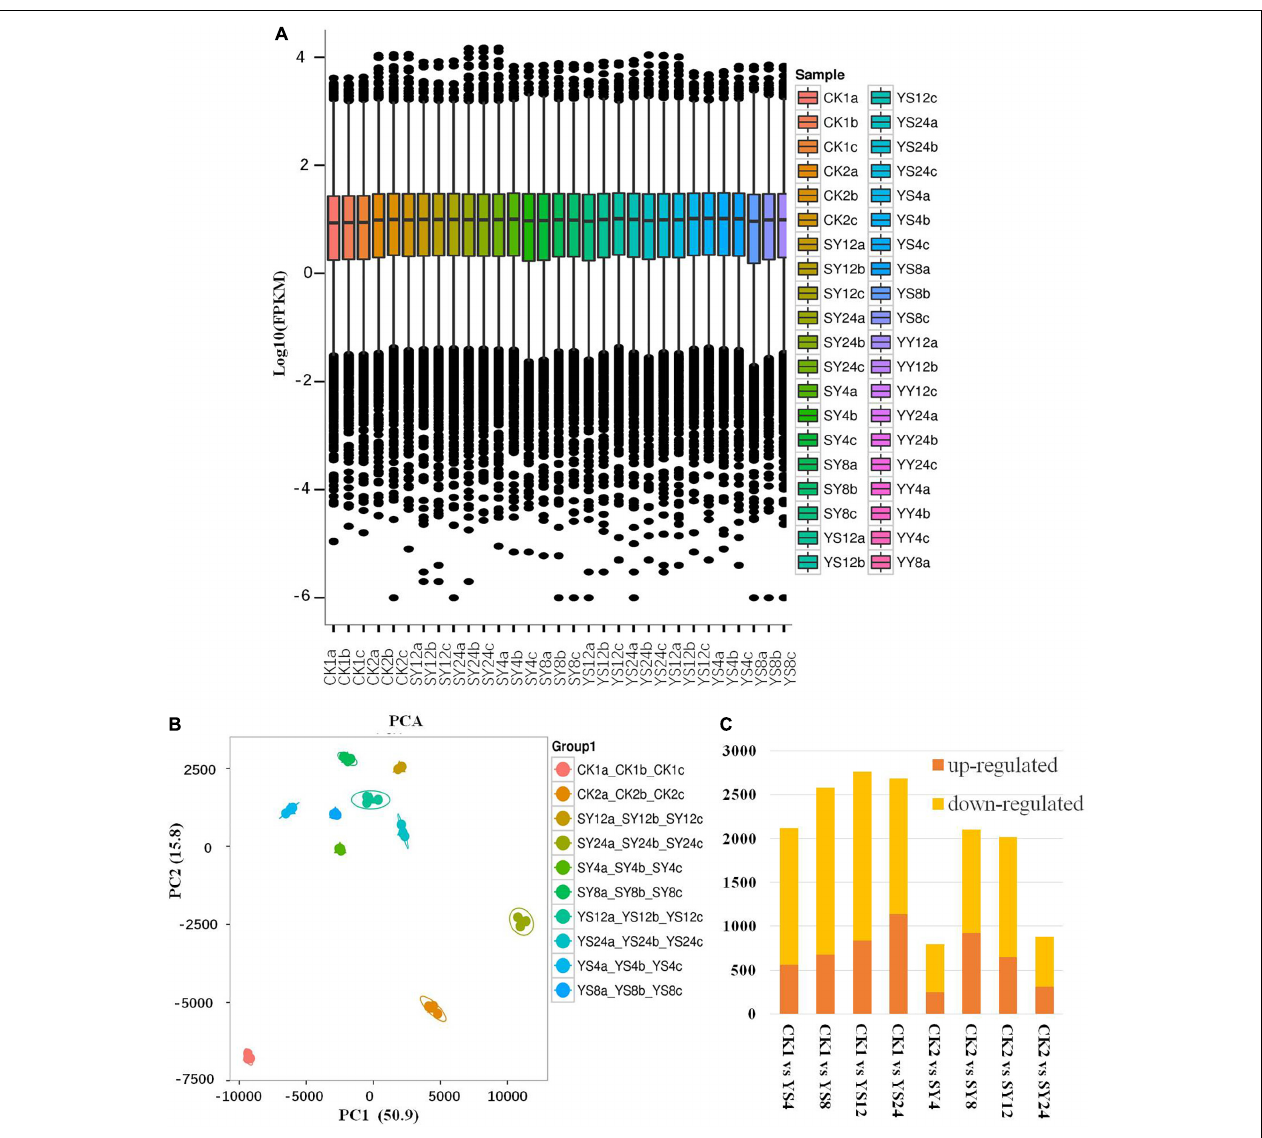
FIGURE 4 | Transcriptional data analysis of Yiduo and Shixia. (A) Overall distribution of gene expression. (B) Principal component analysis of the gene expression data among the replicates of the treatments. (C) Summary of the differentially expressed genes in longan sepal pistils. Y, Yiduo; S, Shixia; CK1, Yiduo sepal-pistil before pollination, and CK2, Shixia sepal-pistil before pollination. The numbers with treatments represent time after